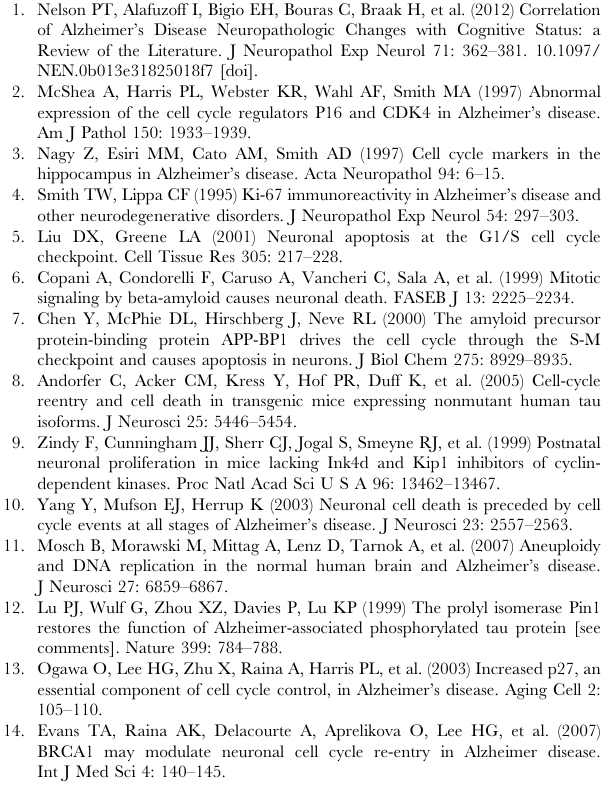
Table S2 Demographic characteristics of study cohorts used for gene and protein expression analyses. Table S3 TaqMan gene expression assays used in the